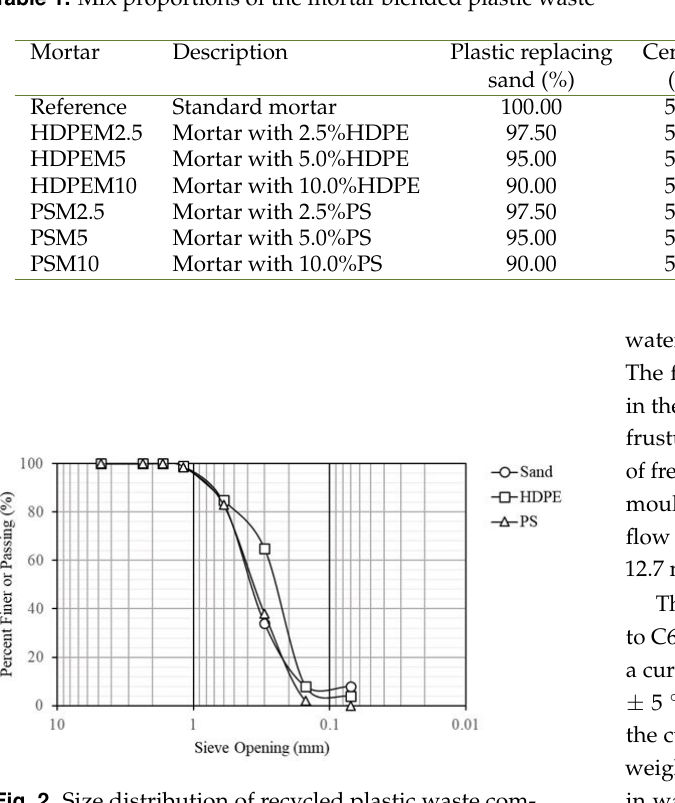
Table 1. Mix proportions of the mortar blended plastic waste